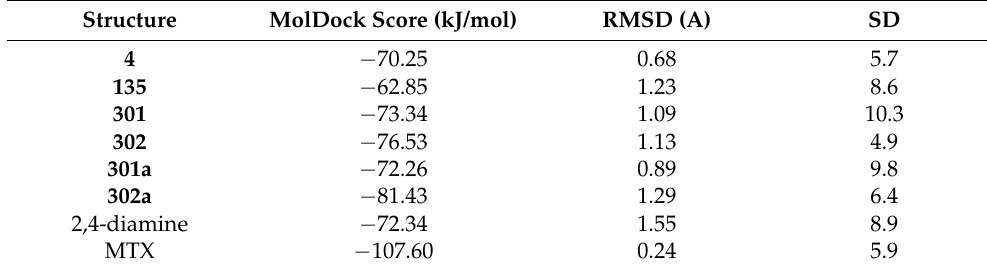
Table 2. MolDock scores of six kaurane-type diterpenes, MTX, and a 2,4-diamine derivative (a dual inhibitor of PTR1/DHFR-TS [19]) against L. major DHFR-TS. SD = standard deviation; RMSD values = root-mean-square deviation. Structure MolDock Score (kJ/mol) RMSD (A) SD 4 −